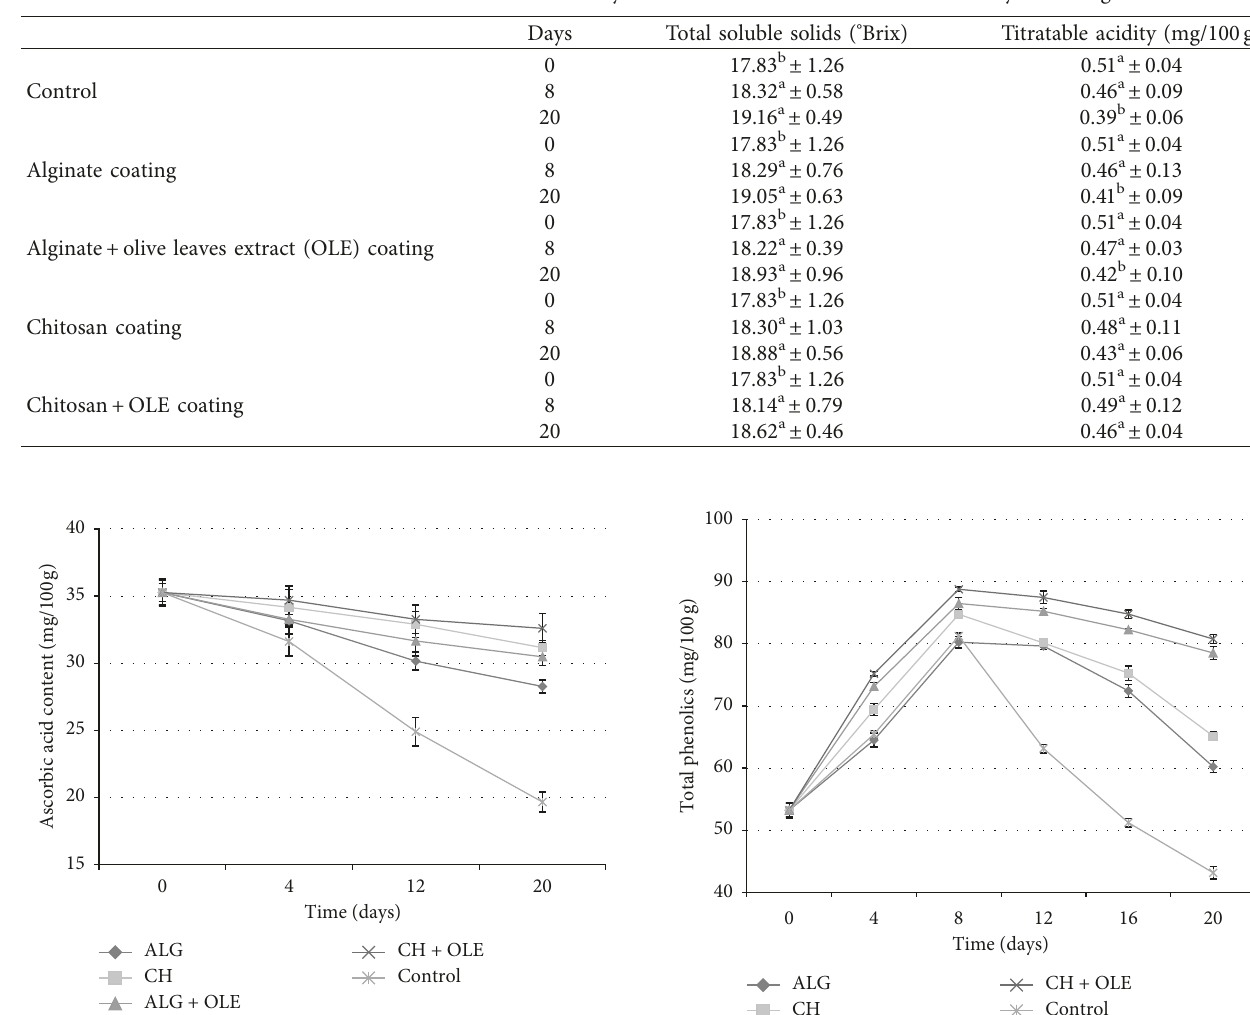
Figure 1: Ascorbic acid content during storage expressed as mg/ 100g fresh weight. ALG: 3% alginate, CH: 1% chitosan, ALG +OLE: 3% alginate+1% olive leaves extract (OLE), CH +OLE: 1% chitosan+1% OLE, and control: distilled water.